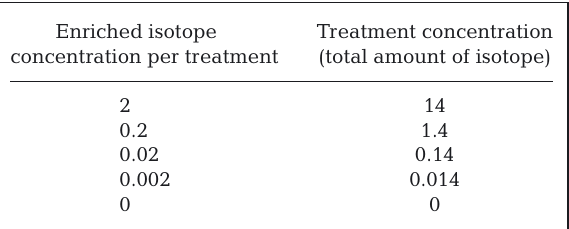
Table 1. Stable isotope ( 134 Ba, 135 Ba, 136 Ba, 137 Ba, 26 Mg, 86 Sr, 87 Sr) enrichment concentrations (µg g −1 broodfish) used for transgenerational marking of Atlantic salmon Salmo salar (n = 6 broodfish treatment −1